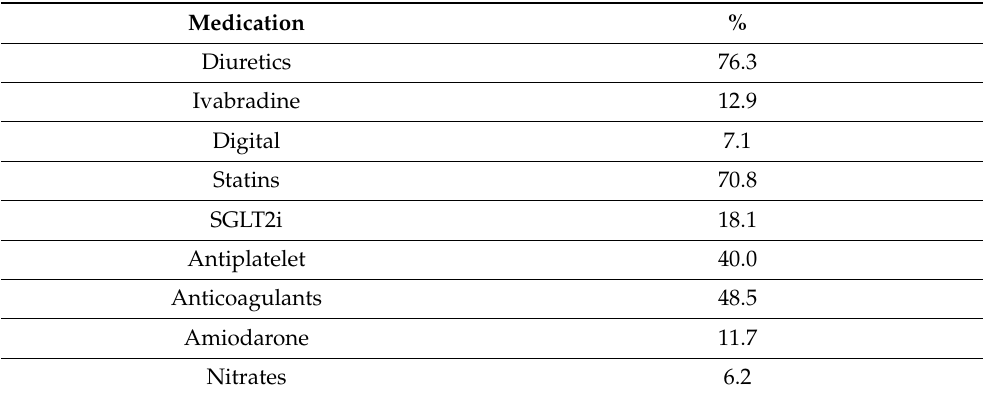
Table 2. Medication at the time of inclusion at the baseline visit.